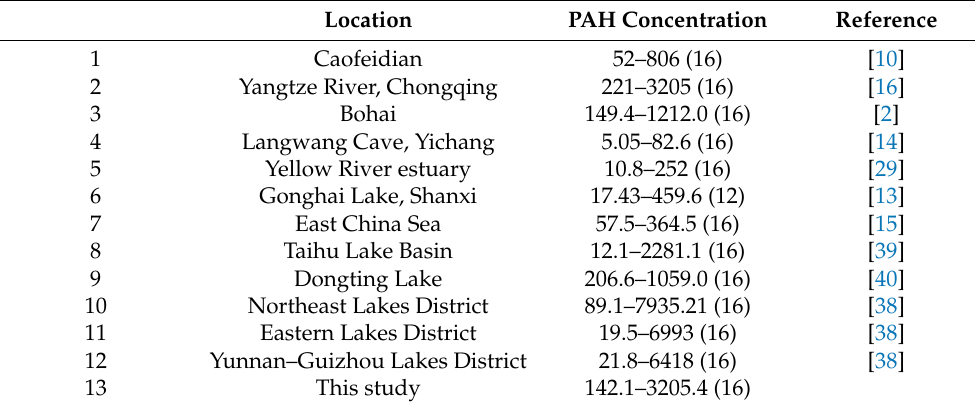
Table 2. Residues of PAHs in sediments of freshwater lakes/rivers in China ( µ g · kg − 1